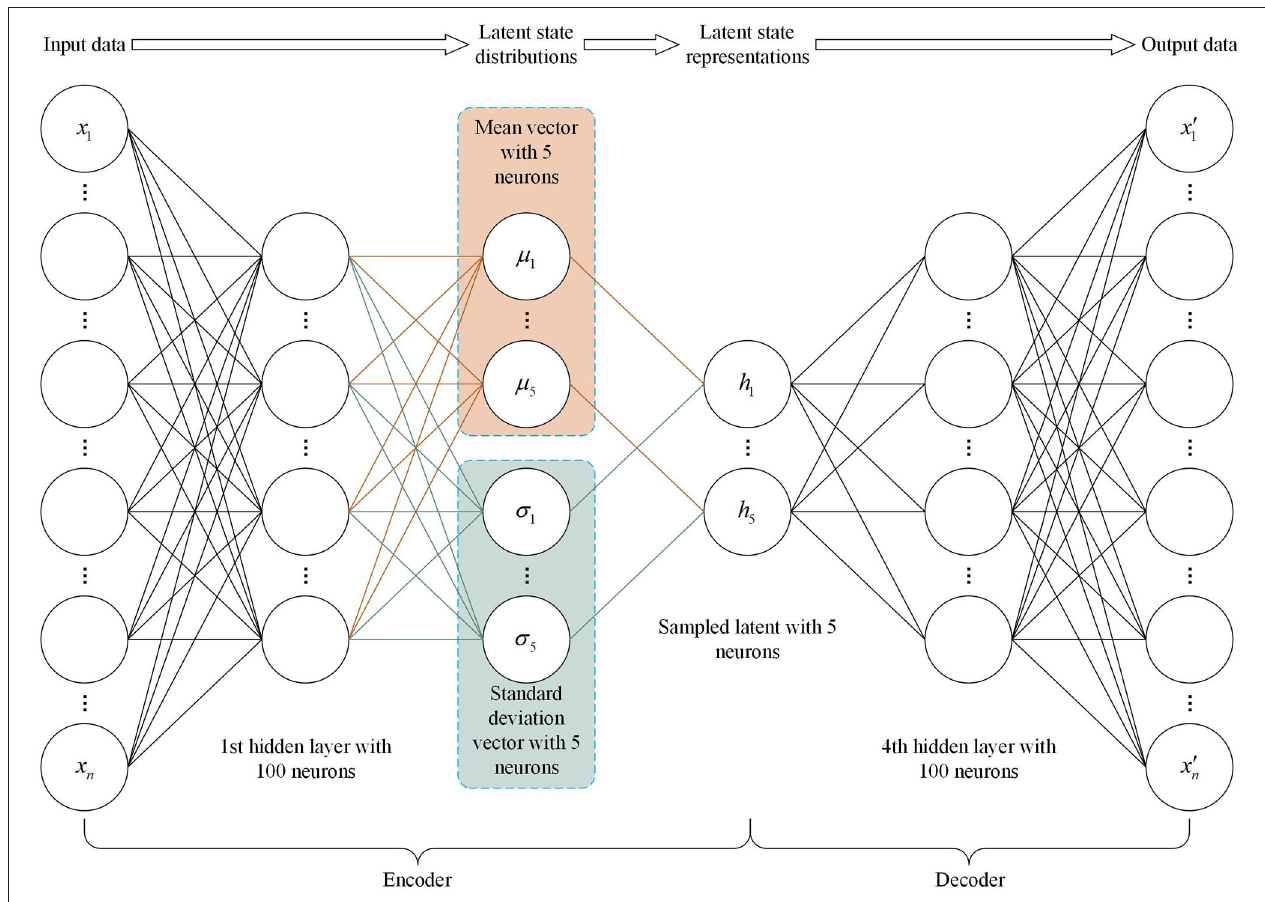
FIGURE 6 | Architecture of the variational